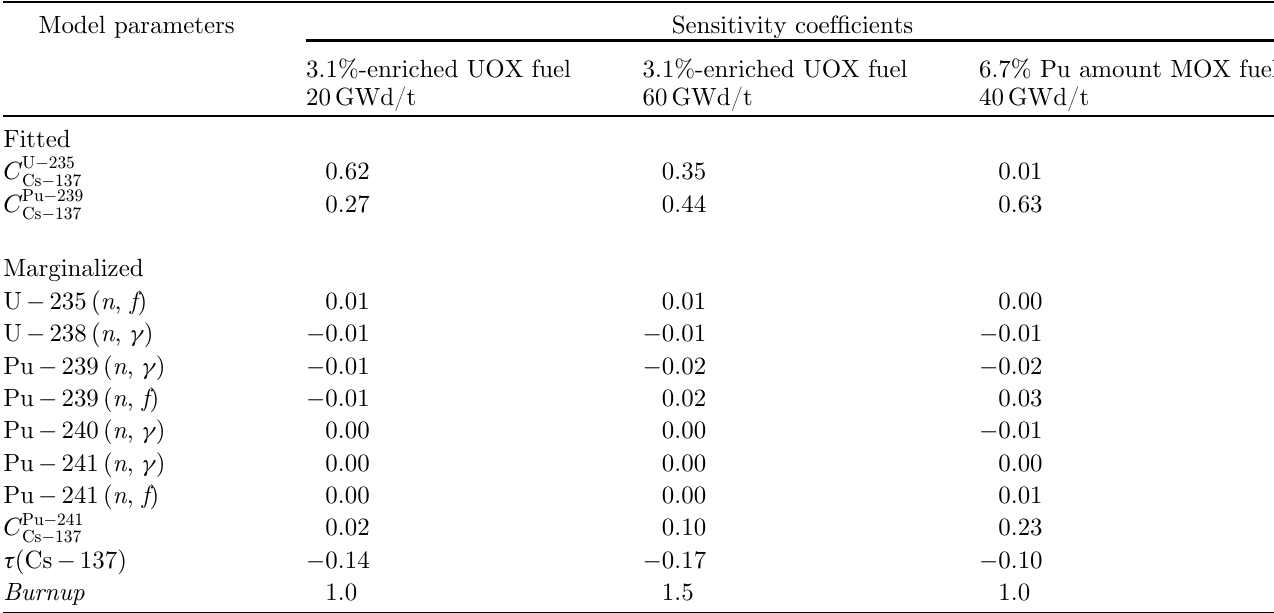
Table 3. Model parameters used for the study and their sensitivity coef fi cient for a 3.1%-enriched UOX fuel at 20 and 60GWd/t, and a 6.7% Pu amount MOX fuel at